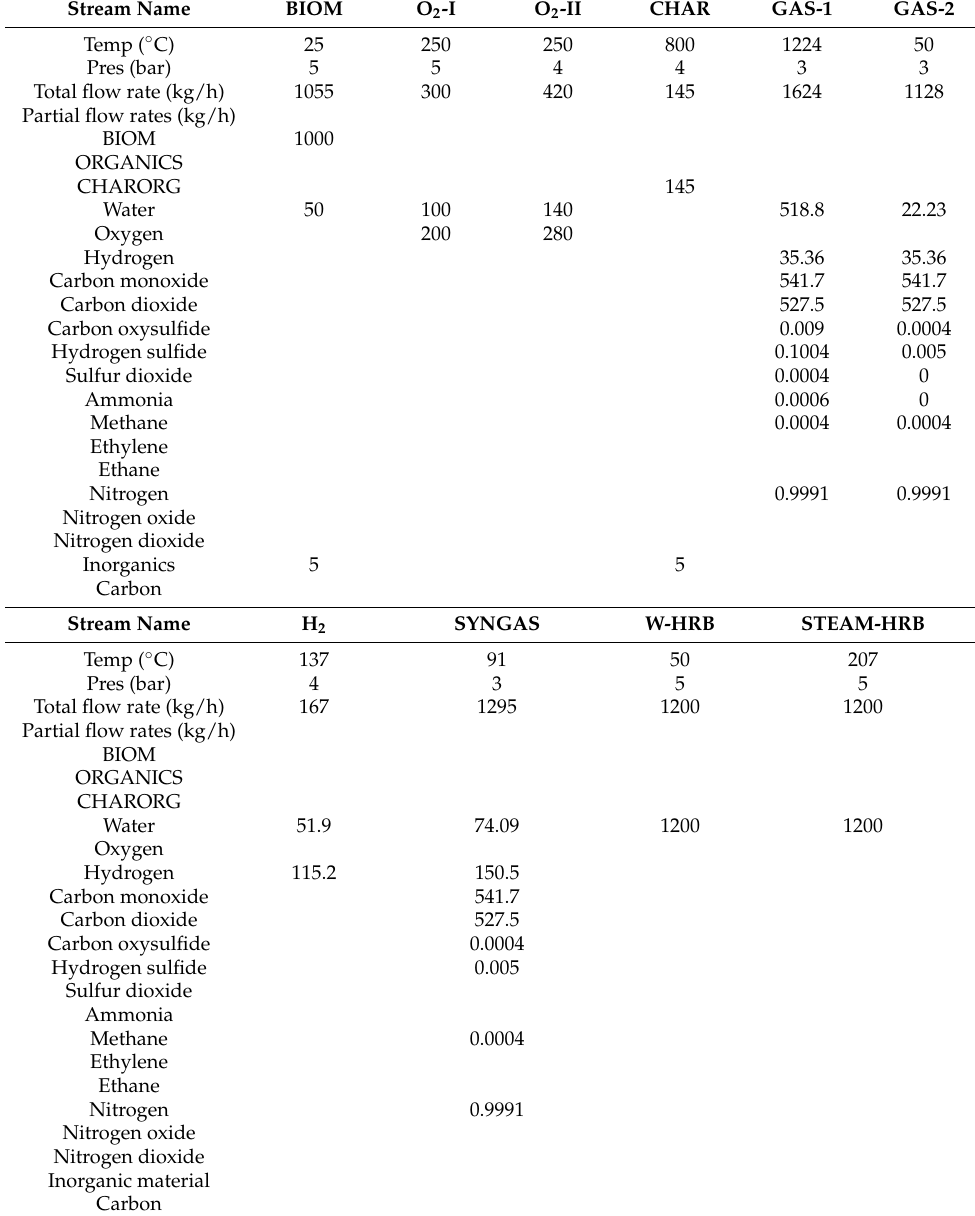
Table 4. Stream compositions, as